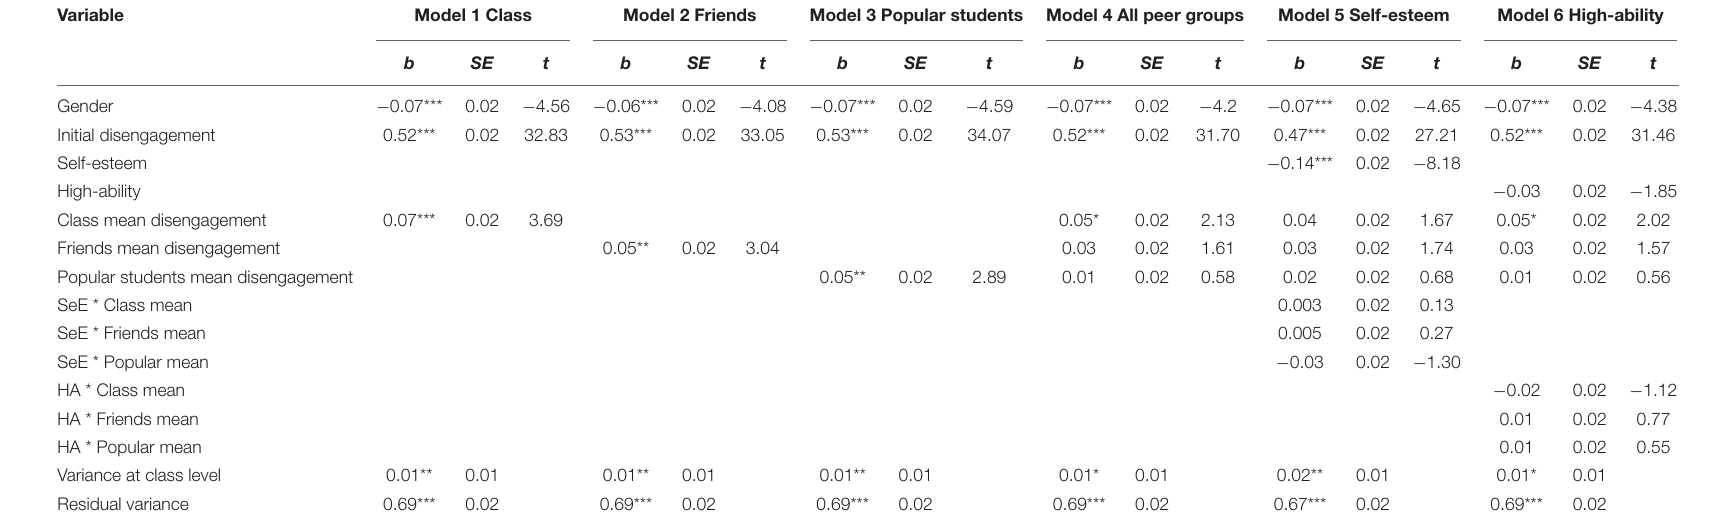
TABLE 3 | Multilevel models of peer group effects on behavioral disengagement ( N = 2,049).